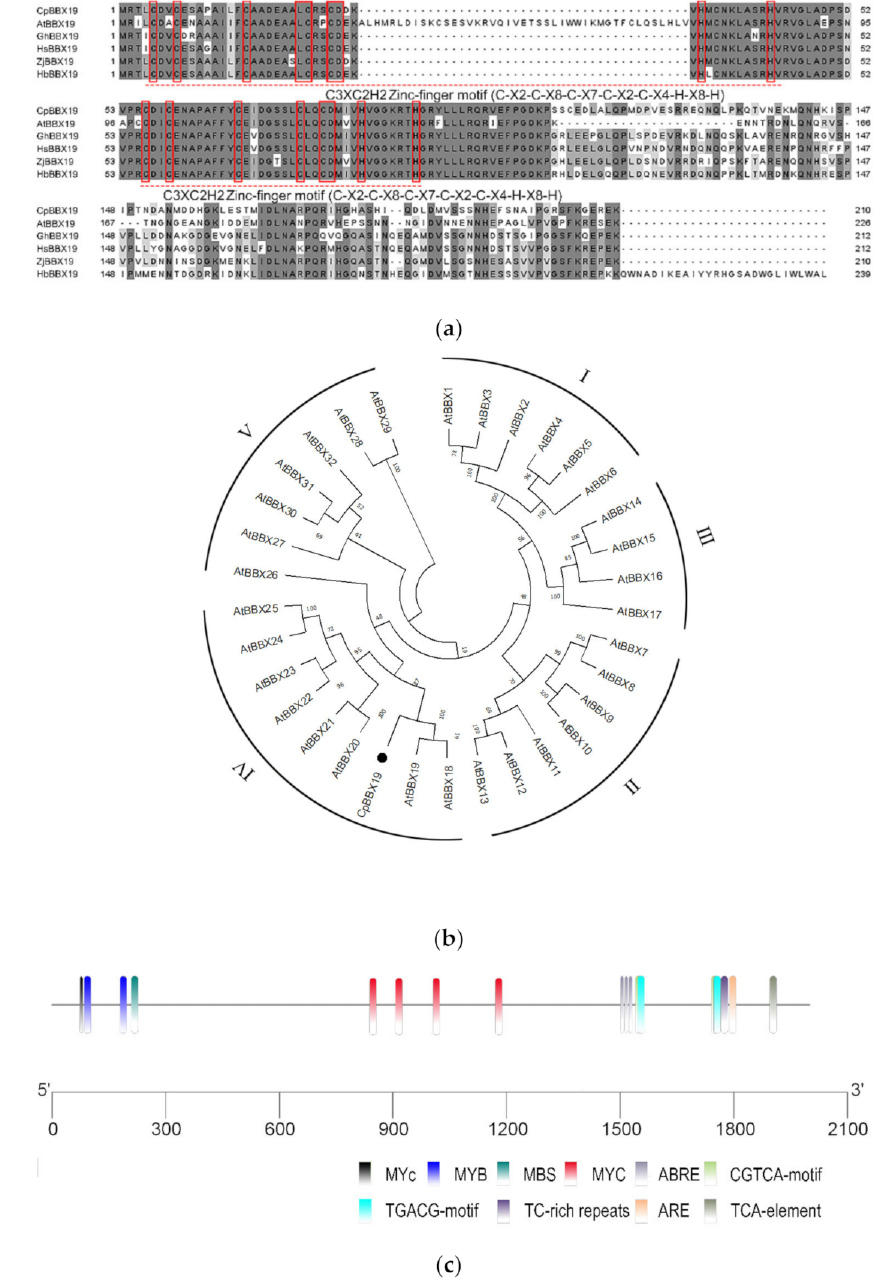
Figure 1. Characterization of CpBBX19 . ( a ) Multiple sequence alignment of CpBBX19 with BBX19 proteins from Arabidopsis thaliana (accession number NP_001190958.1), Gossypium hirsutum (XP_016697629.1), Hibiscus syriacus (XP_039058672.1), Ziziphus jujube (XP_015892301.1), and Hevea brasiliensis (XP_021655083.1). Identical and similar amino acids are shaded in gray and light gray, respectively, and conserved zinc-finger motifs are marked by red boxes. ( b ) Phylogenetic analysis of CpBBX19 and BBX proteins from Arabidopsis . MEGA 6 software with the neighbor-joining (NJ) method (1000 bootstrap repeats) was used to reconstruct the phylogenetic tree. Accession numbers of the protein sequences used for phylogenetic analysis are shown in Table S3. ( c ) Cis -acting elements in the promoter of CpBBX19